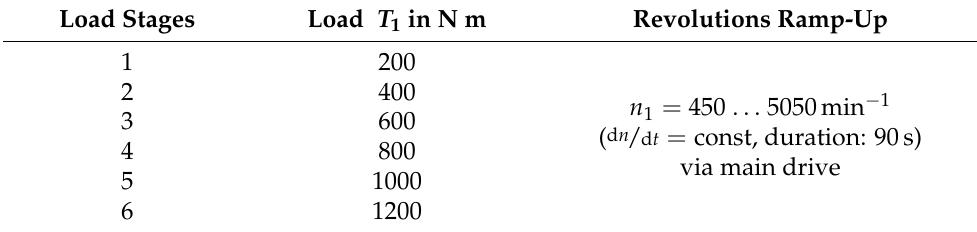
Table 4. Operating conditions used in the test runs.